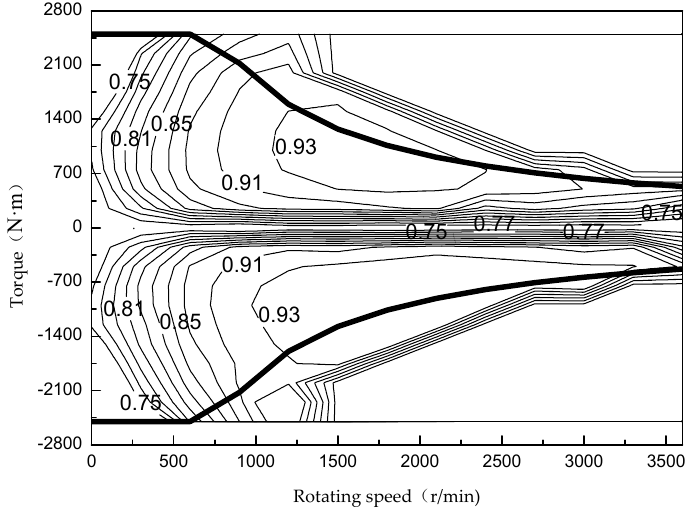
Figure 2. Motor characteristic curve.